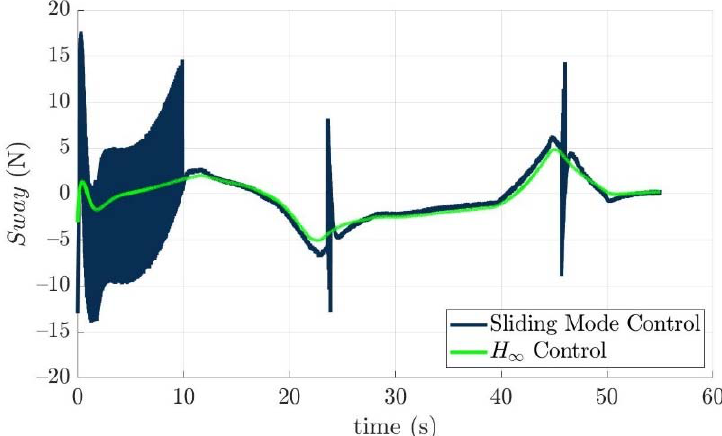
Figure 16. Sway forces of the developed torpedo-like underwater vehicle with respect to the sliding mode control law and the nonlinear H ∞ control law.